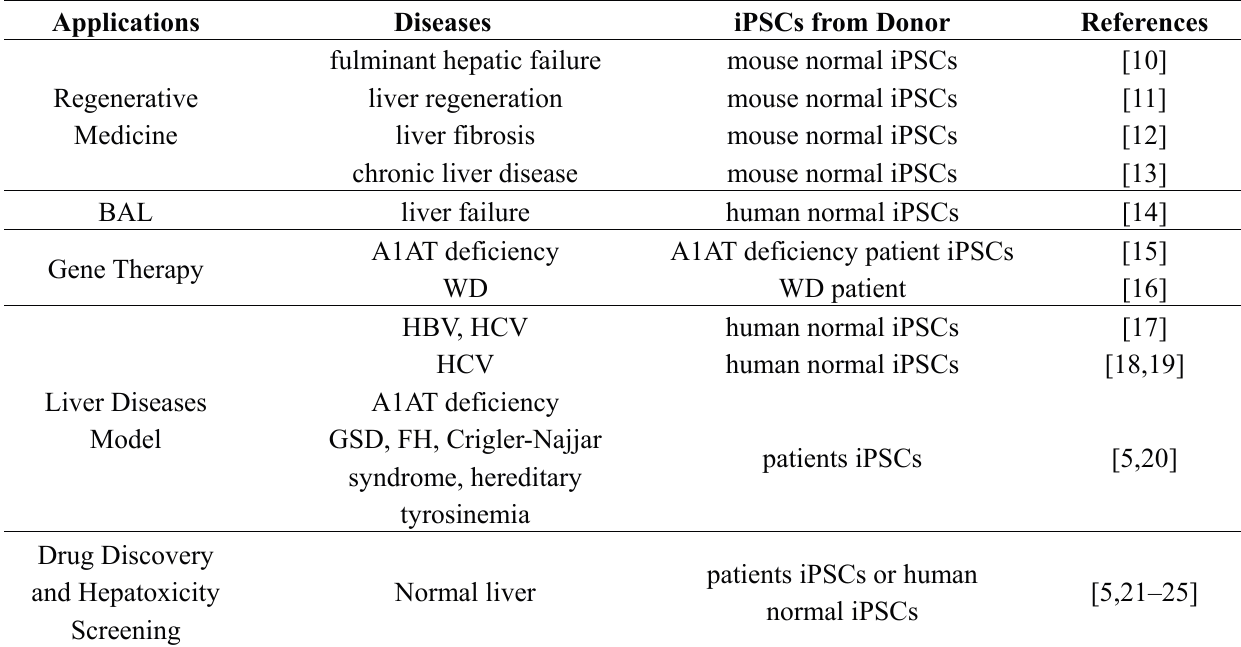
Table 1. Applications of iPSCs in liver